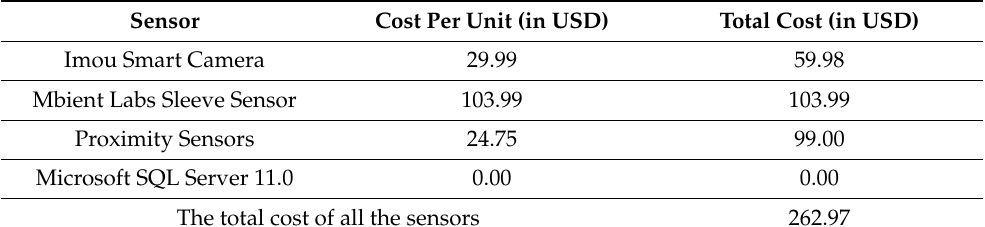
Table 1. Costs of the sensors that are necessary for the development of the proposed system. Sensor